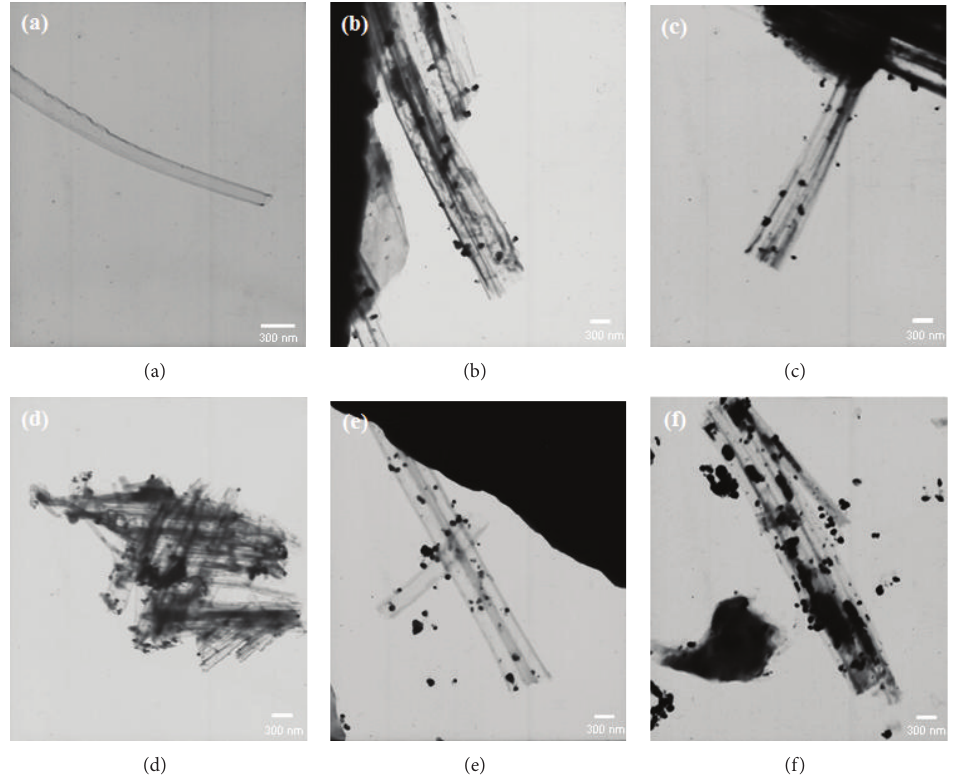
Figure 4: TEM images of HNO 3 functionalized 𝛼 CNTN/Ag nanohybrids at different molars of AgNO 3 : (a) 0M, (b) 0.01M, (c) 0.05 M, (d) 0.1M, (e) 0.5 M, and (f)